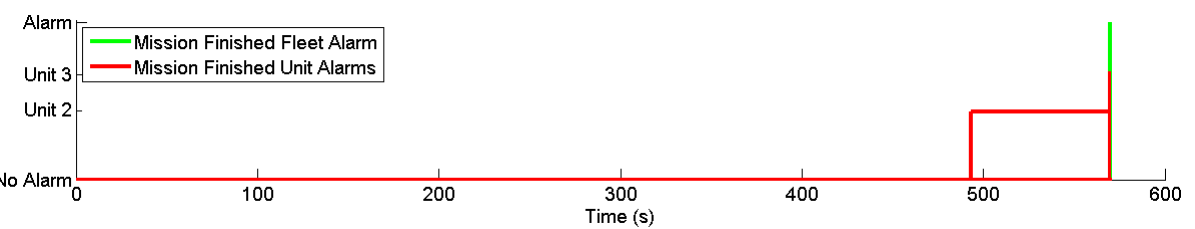
Figure 15. Collision supervisor outputs and unit states during the mission.